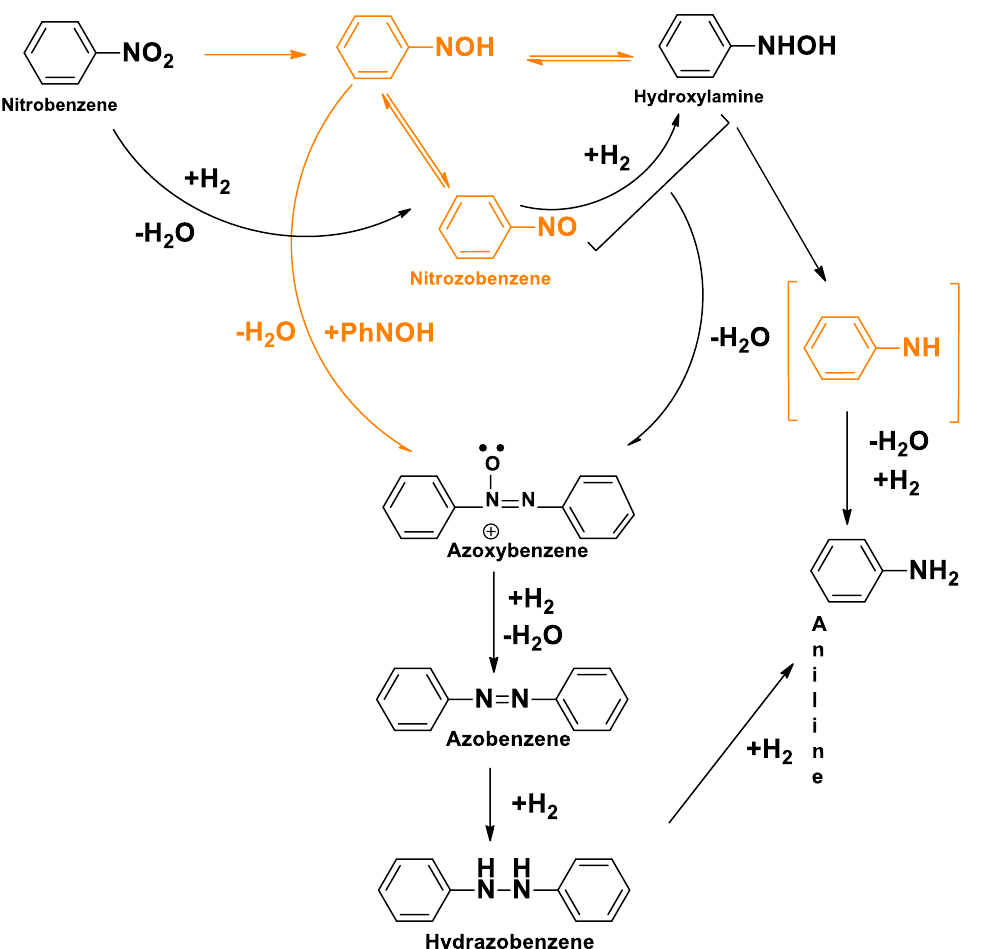
Figure 2. Possible reaction pathways of the hydrogenation of nitrobenzene to aniline. Presentation of Haber (black) and difference by Gelder (orange) mechanism.